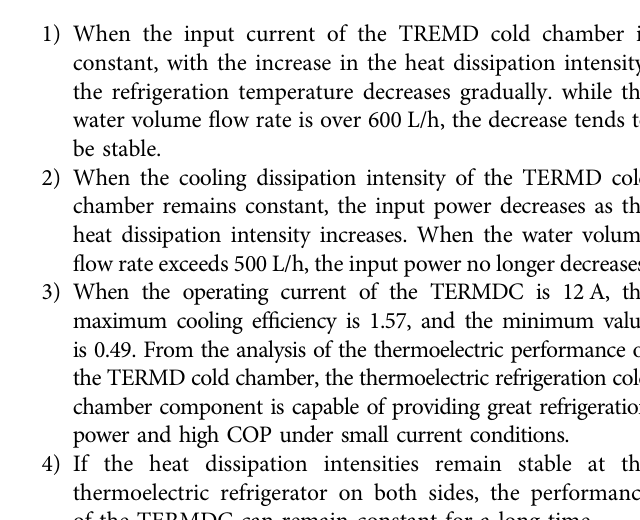
FIGURE 10 | Real-time temperature curves over 4 hours of continuous